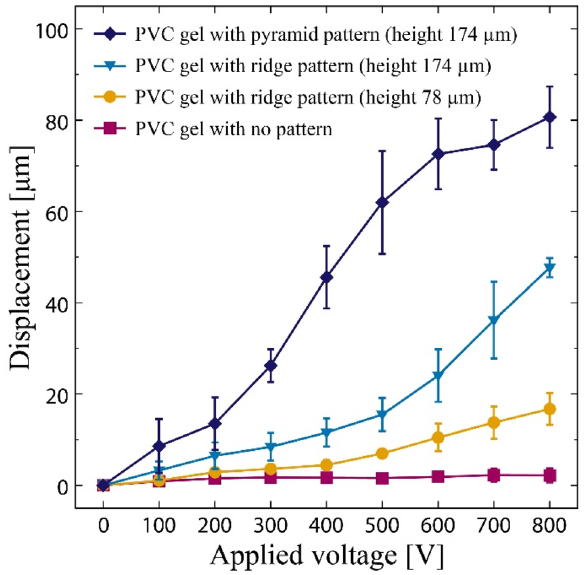
Figure 4. Displacement of the PVC gel sheets in the thickness direction as a function of the applied voltage. Every gel sheet was measured three times and the average was reported.